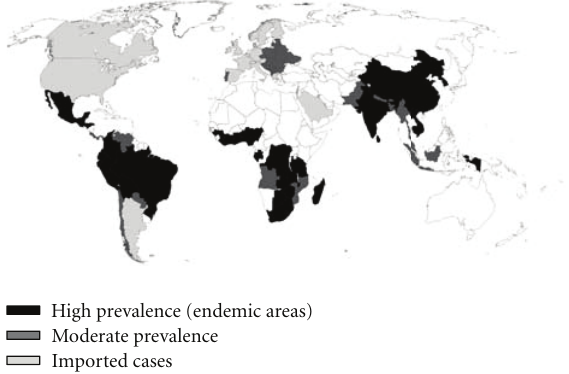
Figure 1: World map showing countries where cysticercosis is